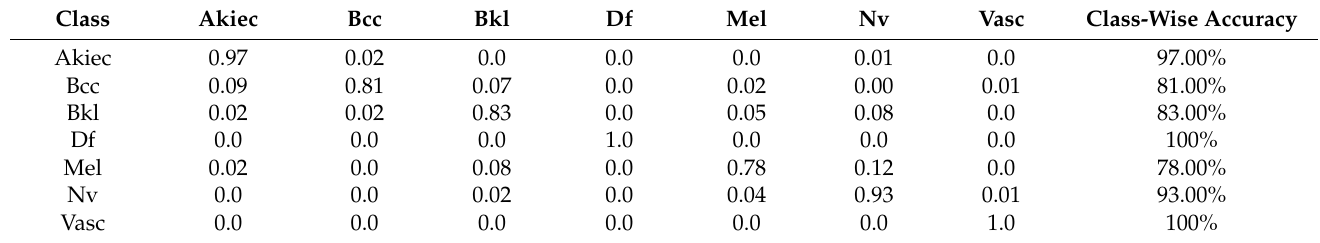
Table 2. Confusion matrix of the proposed model without the preprocessing stage.